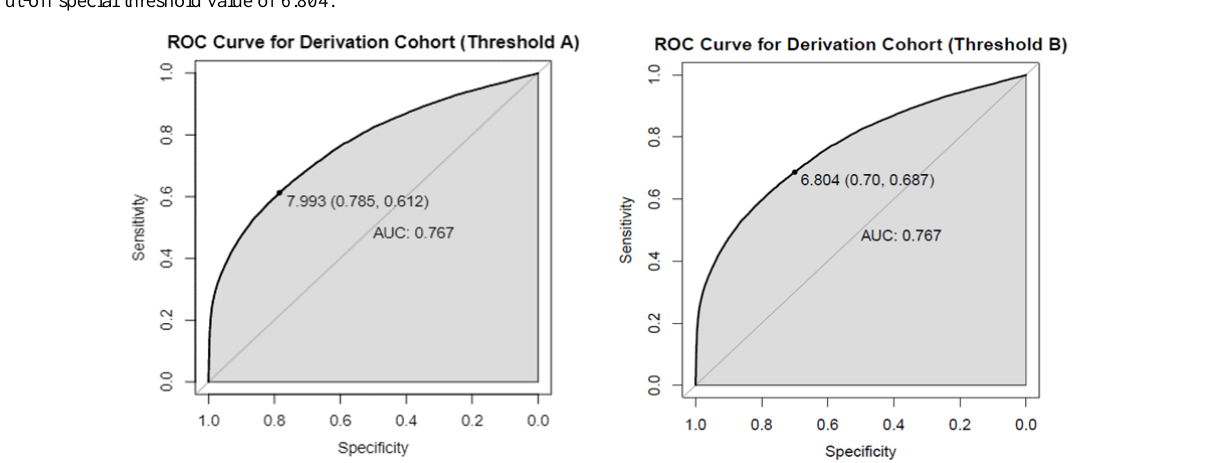
Figure 4. Receiver operating characteristic (ROC) curve for the derivation cohort. Threshold A: Cut-off regular threshold value of 7.993; Threshold B: Cut-off special threshold value of